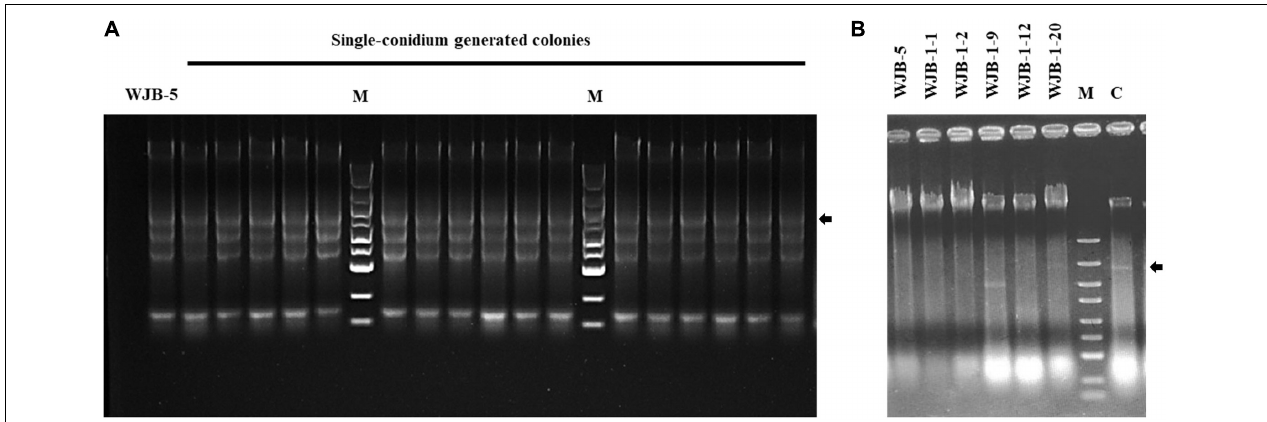
FIGURE 5 | Agarose gel electrophoresis of dsRNA extracted from the mycelia of Melanconiella theae strains. (A) dsRNA extraction from the mycelia of single-conidium generated colonies derived from strain WJB-5 conidia. (B) dsRNA extraction from six strains (WJB-5, WJB-1-1, WJB-1-2, WJB-1-9, WJB-1-12, and WJB-1-20) after being treated with hyphal tipping combined with antiviral extracts. (C) Untreated WJB-5 as a control. M: DL5000 DNA marker (100; 250; 500; 750; 1,000; 1,500; 2,000; 3,000; and 5,000 bp). The arrows indicate the target viral dsRNA